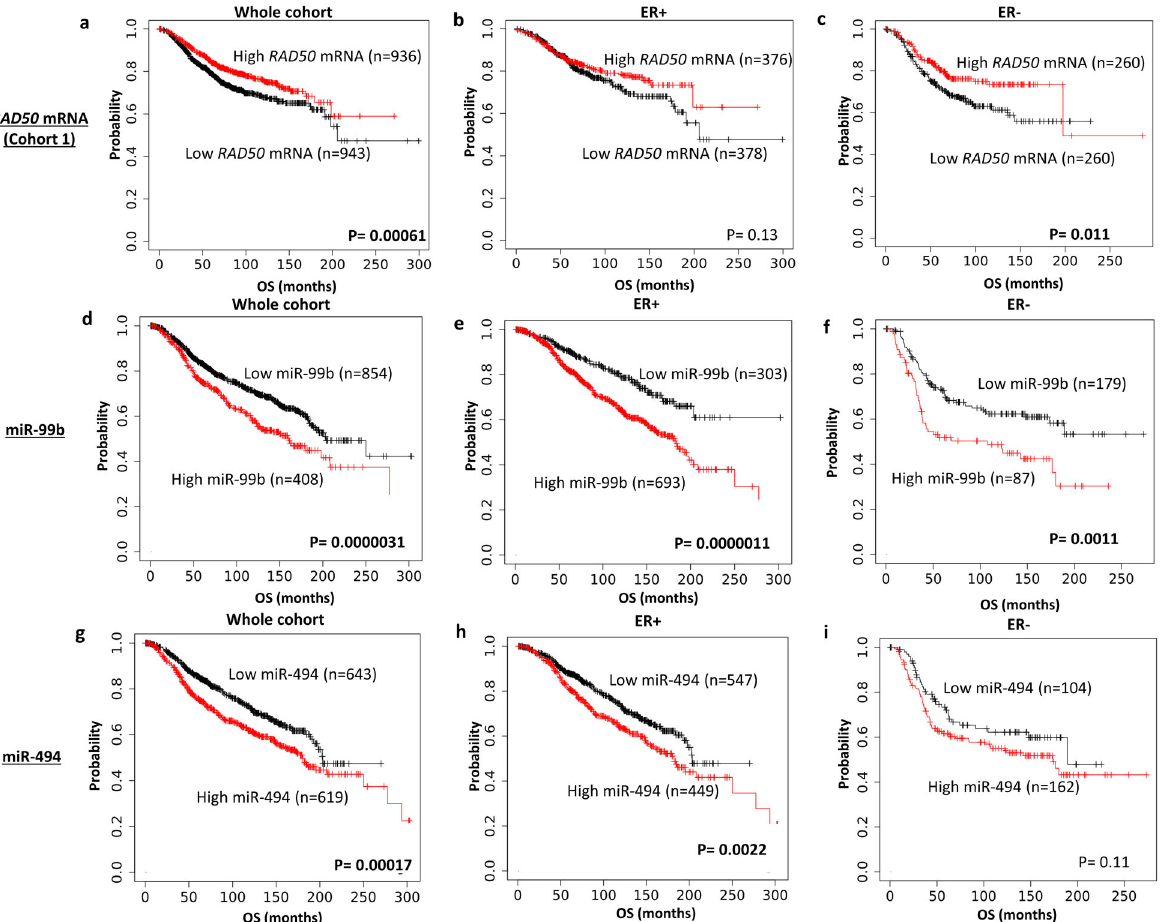
Fig. 3 MRN transcripts and survival. a Kaplan – -Meier curve for RAD50 mRNA expression and breast cancer-speci fi c survival (BCSS) in the whole cohort. b Kaplan – Meier curve for RAD50 mRNA expression and BCSS in ER + cohort. c Kaplan – Meier curve for RAD50 mRNA expression and BCSS in ER − cohort. d Kaplan – Meier curve for has-miR-99b expression and BCSS in the whole cohort. e Kaplan – Meier curve for has-miR- 99b expression and BCSS in ER + cohort. f Kaplan – Meier curves for has-miR-99b expression and BCSS in ER − cohort. g Kaplan – Meier curves for has-miR-494 expression and BCSS in the whole cohort. h Kaplan – Meier curve for has-miR-494 expression and BCSS in ER + cohort. i Kaplan – Meier curve for has-miR-494 expression and BCSS in ER −